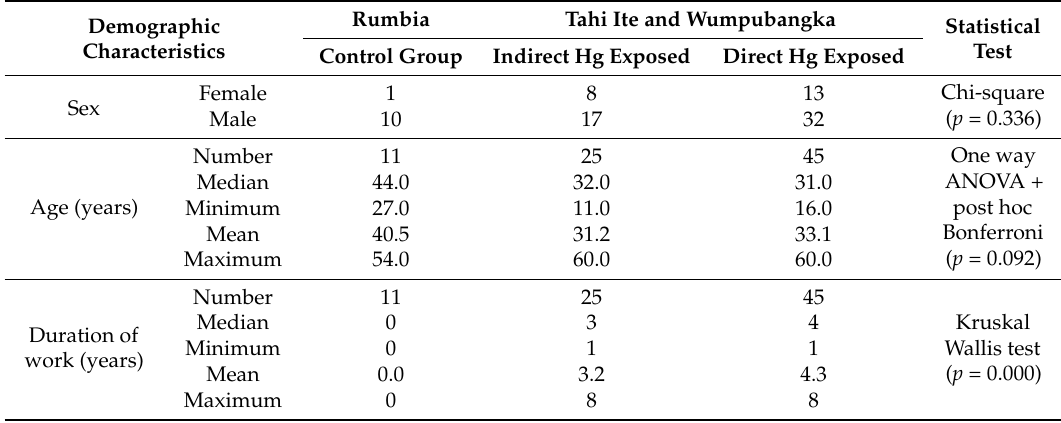
Table 1. Number, gender, and age of participant, distribution by group and exposure status. Rumbia Tahi Ite and Wumpubangka Statistical Demographic Characteristics TestControl Group Indirect Hg